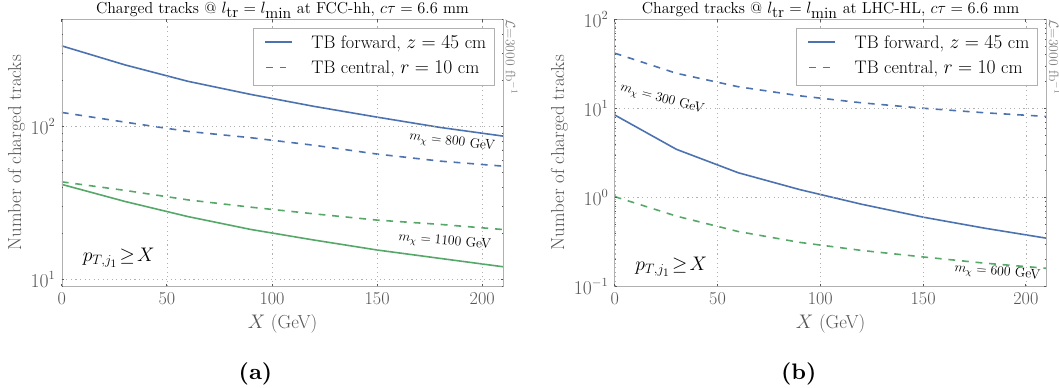
Figure 11. (a) Number of charged tracks in track-based analyses, at z = 45 cm and r = 10 cm in central region, as a function of a cut on the transverse momentum of the hardest recoil jet p T;j > X . The total rate is normalized to the NLO production cross section for a weak doublet 1 with mass 1.1 TeV and c(cid:28) = 6 : 6 mm at (a) a 100 TeV pp collider and (b) a 14 TeV pp collider, with 3000 fb (cid:0) 1 of integrated